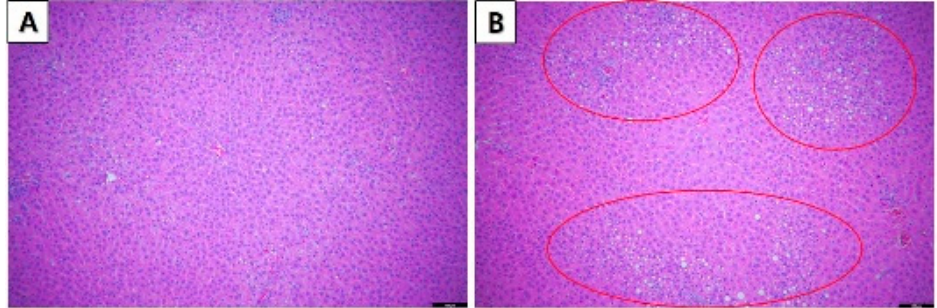
Figure 1. Histopathological changes in female SD rats in the 28-day oral administration toxicity test. ( A ) Normal microscopic structure of the liver of a female SD rat (×100 magnification). ( B ) Fatty change (circle) in the liver of a female SD rat administered 100 mg/kg chlorobutanol (×100 magnification). Scale bar: 100 μ m.